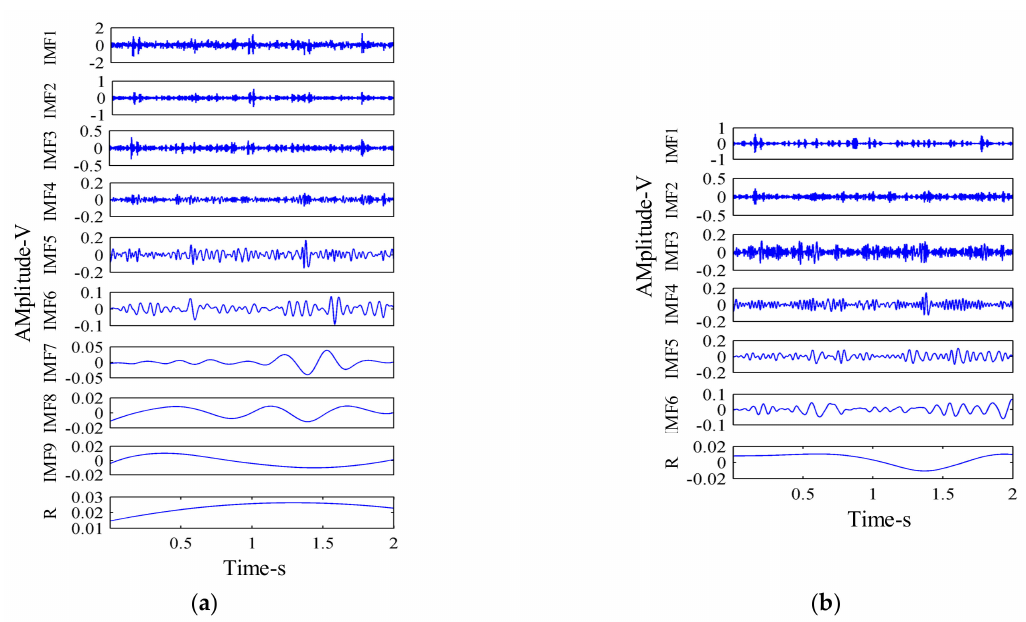
Figure 10. Vibration signal decomposition of hydraulic pump: ( a ) EEMD; and ( b )